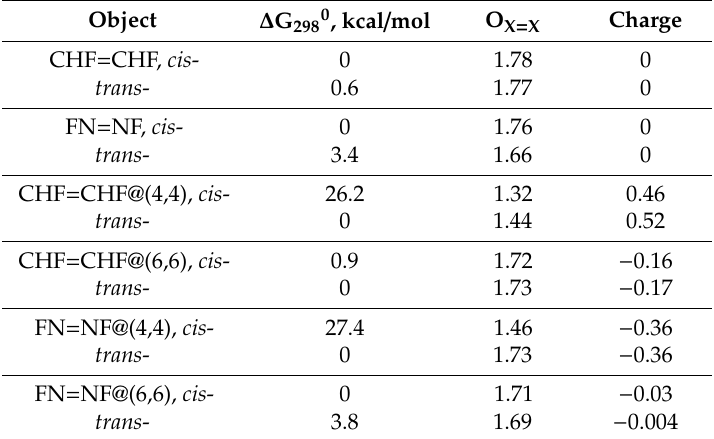
Table 5. Relative energies of geometric isomers of 1,2-difluoroethene and difluorodiazene, their endocomplexes with SWCNTs, the bond order of the double bond, O X = X and the electric charge on the guest molecule (PBE / 3 ζ ) [267,268].